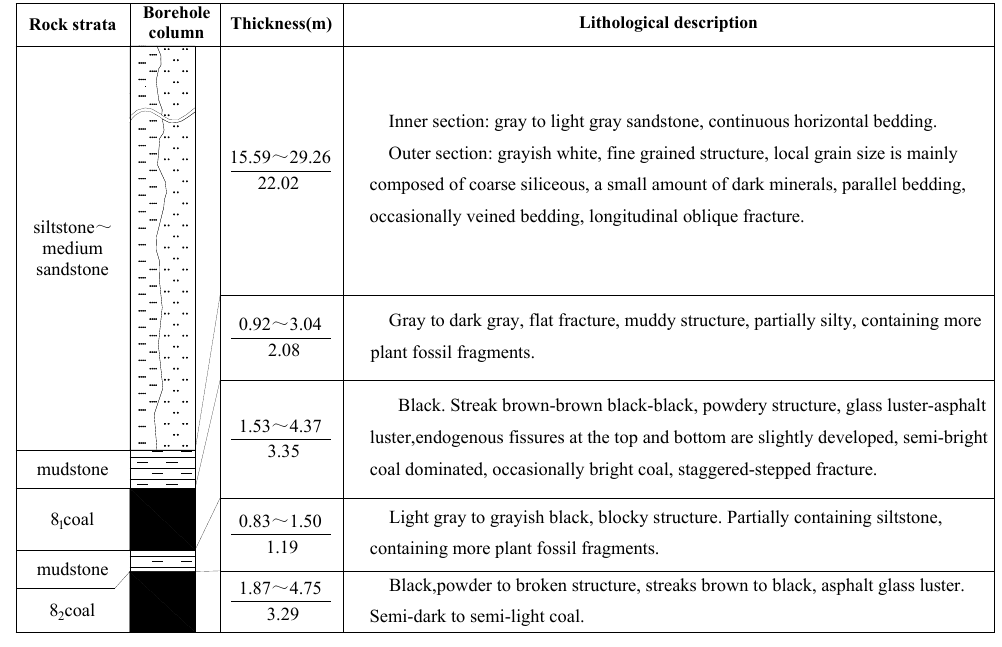
Figure 2. Borehole columnar section of coal seam.